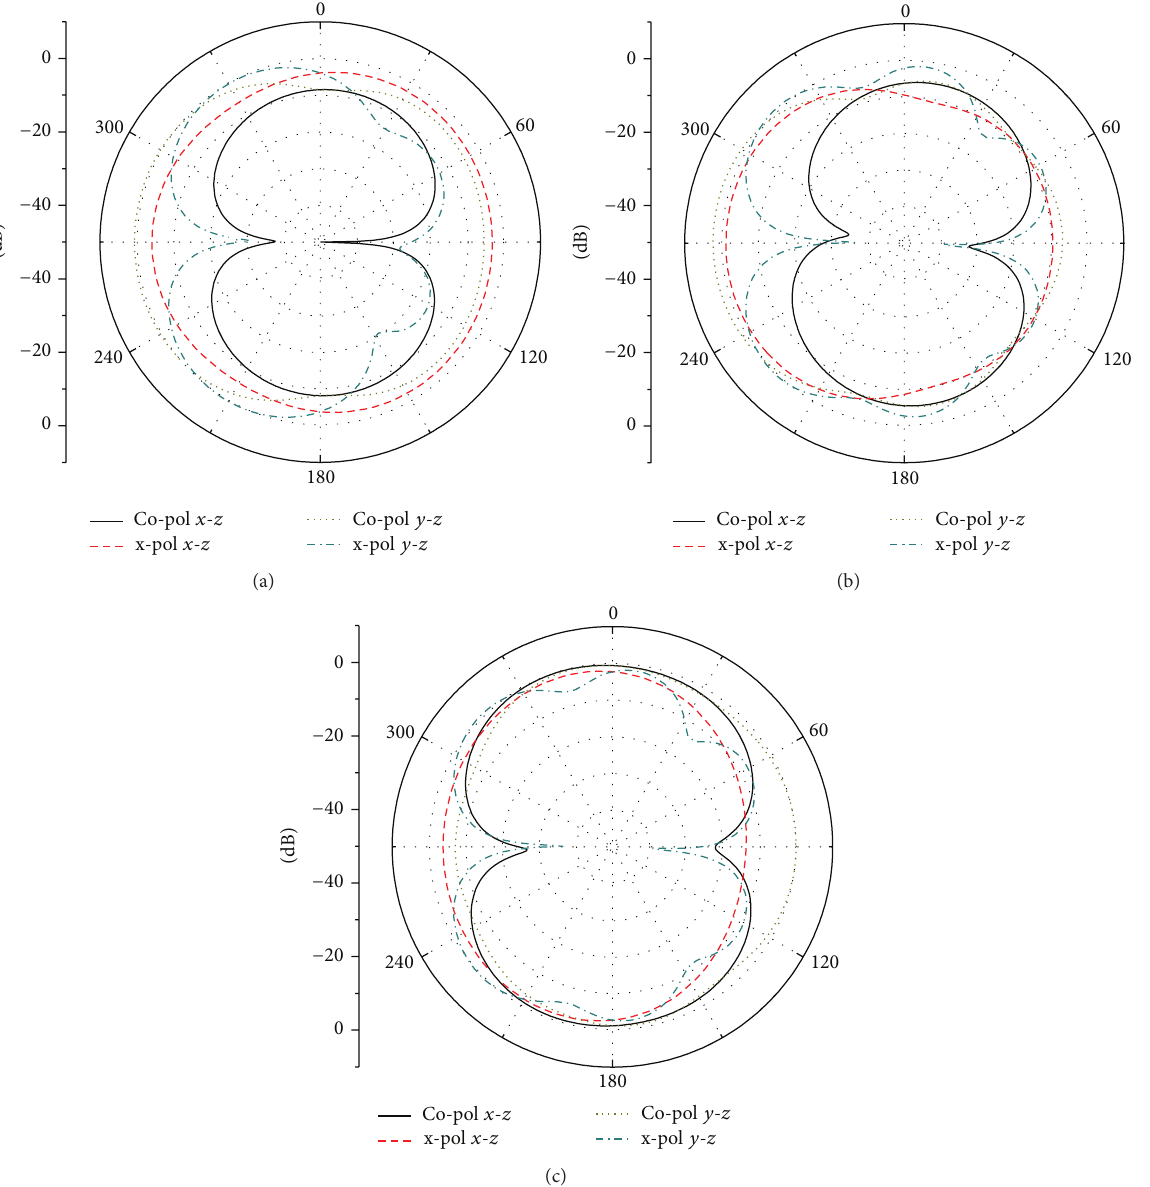
Figure 7: Measured patterns of the proposed antenna at (a) 1.5GHz; (b) 2.4 GHz; (c) 3.5